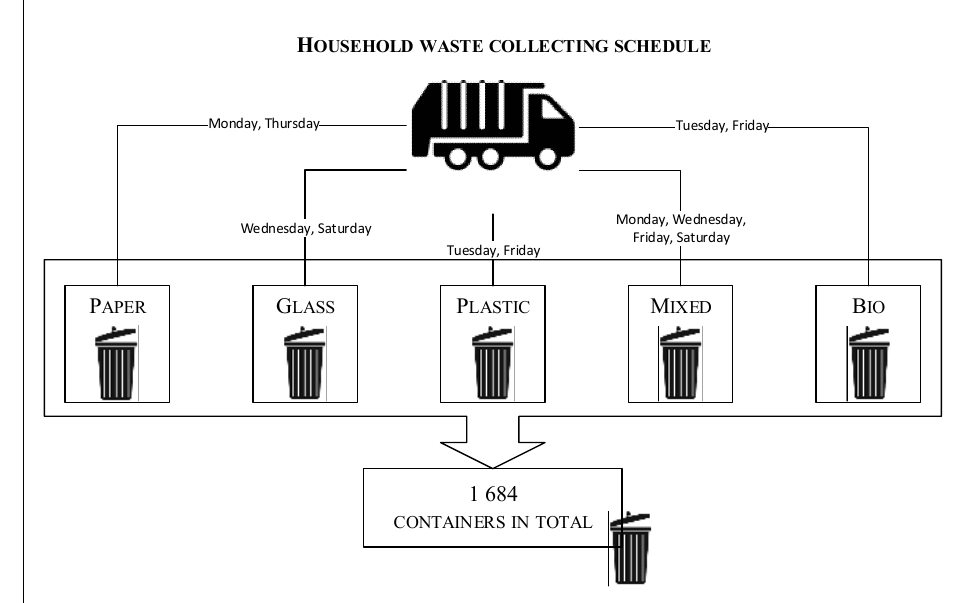
Figure 1. Diagram of household ‐ waste ‐ collection schedule.